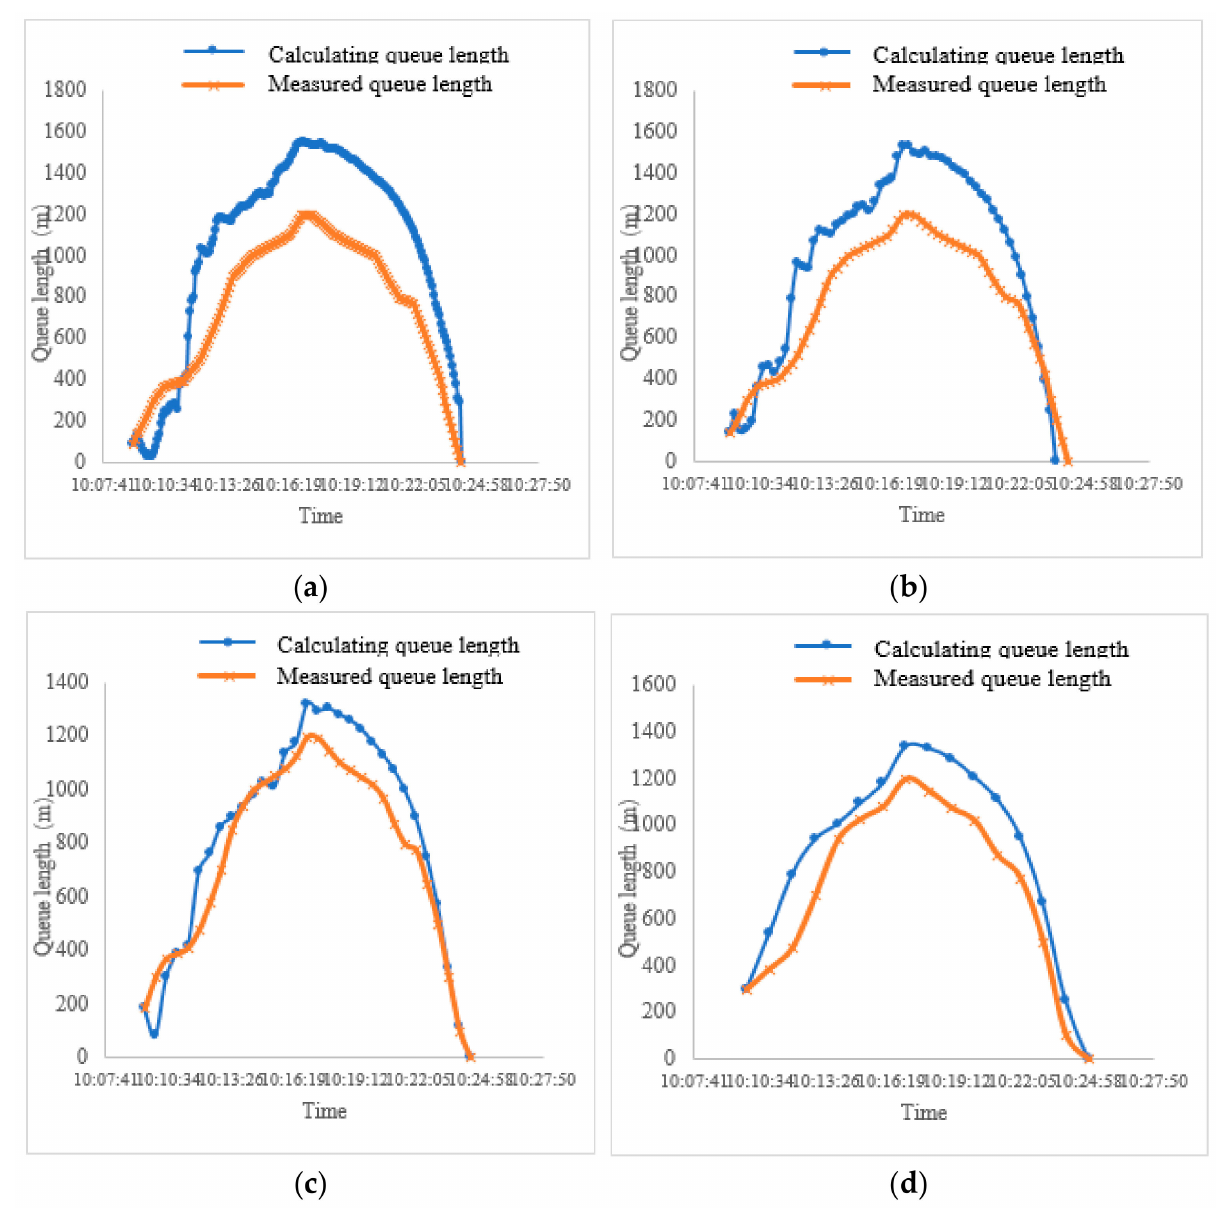
Figure 16. Comparison of calculation results of queue length at different time intervals. ( a ) The time interval T is 5 s, ( b ) The time interval T is 15 s, ( c ) The time interval T is 30 s, ( d ) The time interval T is 60